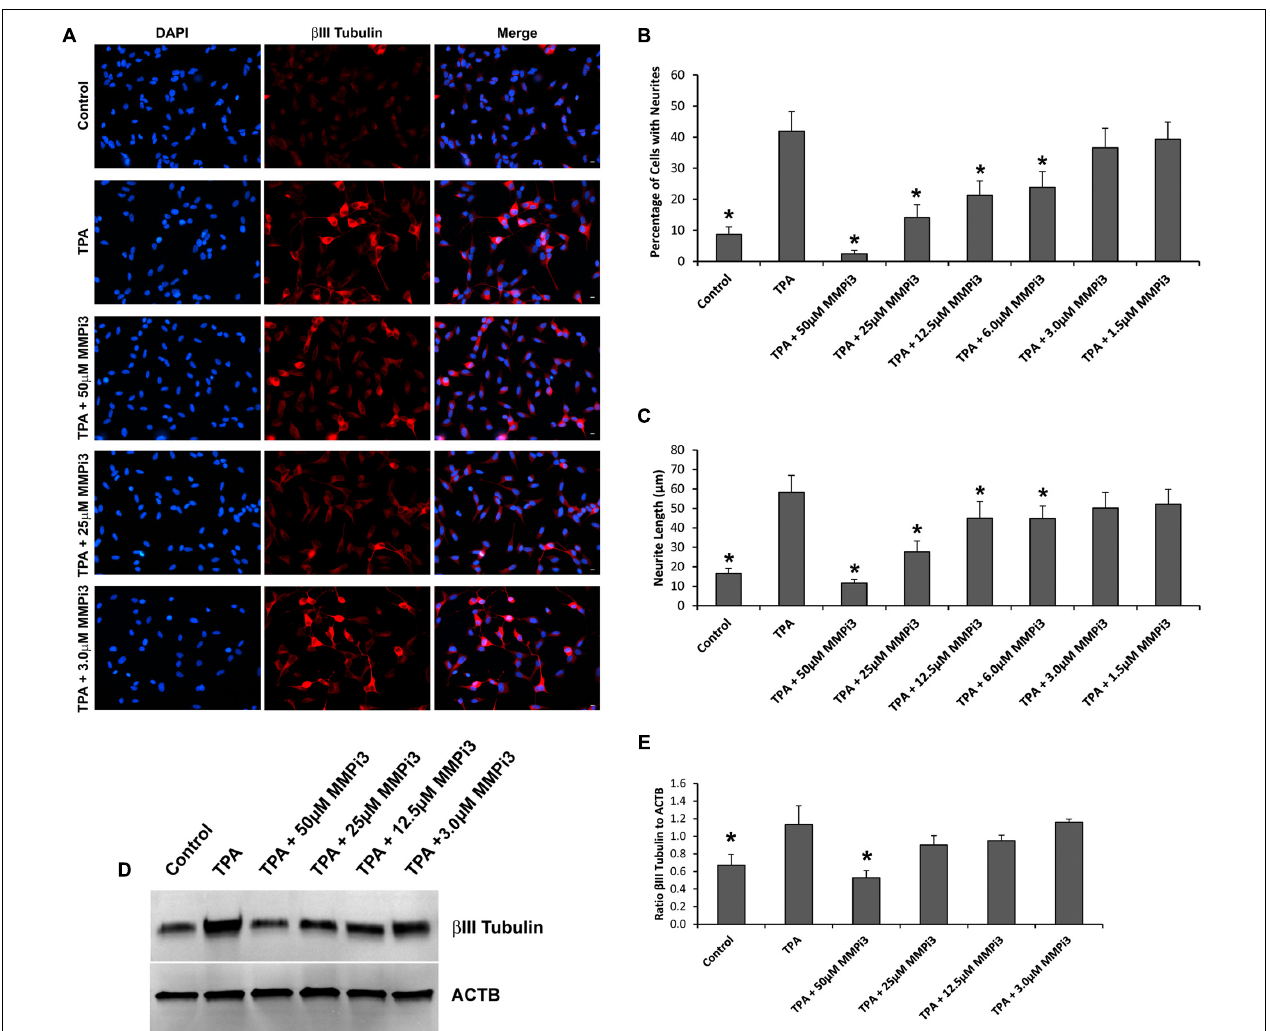
FIGURE 6 | Matrix metalloproteinases inhibition impacts neural differentiation. (A) SH-SY5Y cells under control conditions, treated with TPA, or TPA plus various concentrations of MMP inhibitor III (MMPi3). Shown in blue is DAPI nuclear stain, in red is β III Tubulin. Scale bar = 10 µ m. (B) Percentage of cell with neurite (Mean ± SE) in Control, TPA treated, and TPA plus MMPi3. (C) Neurite length ( µ m) (Mean ± SE) in Control, TPA treated, and TPA plus MMPi3. (D) Western blots of β III Tubulin and β -Actin (ACTB) levels in SH-SY5Y lysates from Control, TPA, and TPA plus MMPi3 treated cells. (E) Ratio (Mean ± SD) of β III Tubulin and ACTB taken from optical density analysis of western blot data. Data are averaged across three independent experiments. * Represents significant difference compared to control at p <